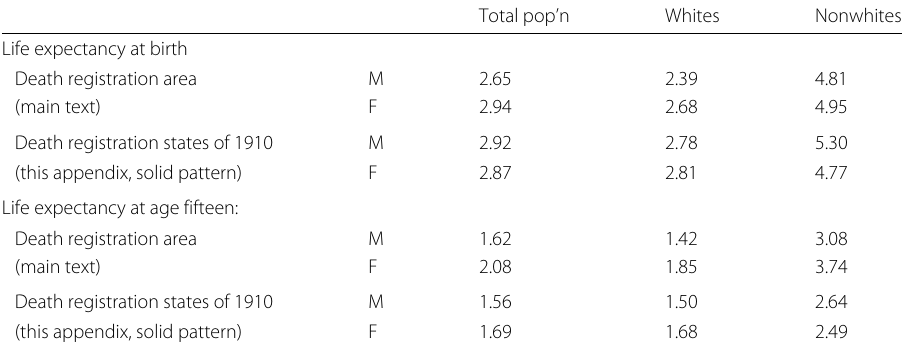
Total pop’n Whites Nonwhites